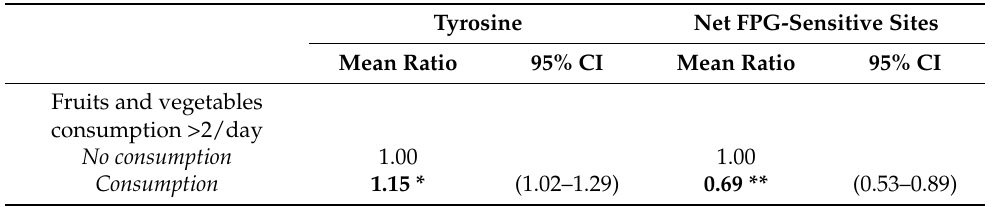
Table 3. Effect of fruit/vegetables consumption on tyrosine and oxidative DNA damage; models adjusted by age, gender, smoking habits, and actual confounders.